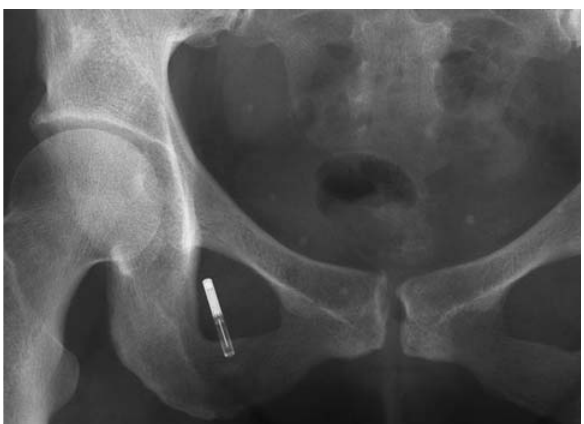
Figure 8 – Bion device (from Bosch JL: The bion device: a minimally invasive implantable ministimulator for pudendal nerve neuromodulation in patients with detrusor overactivity incontinence. Urol Clin North Am. 2005; 32: 109-12, with